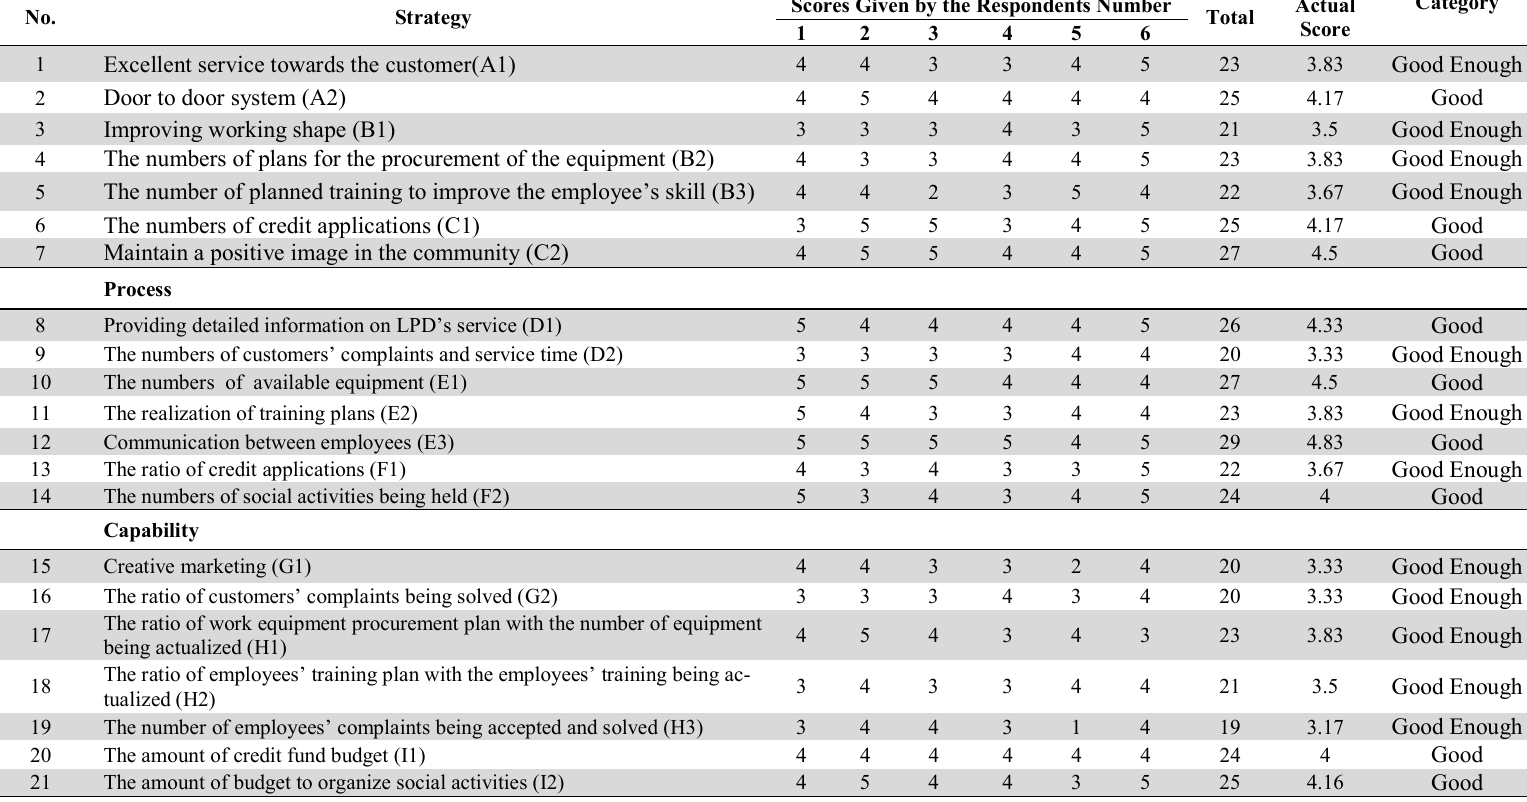
Achievement Measurement Results Of Each KPI (Score Table of Each Strategy Criteria Elements)